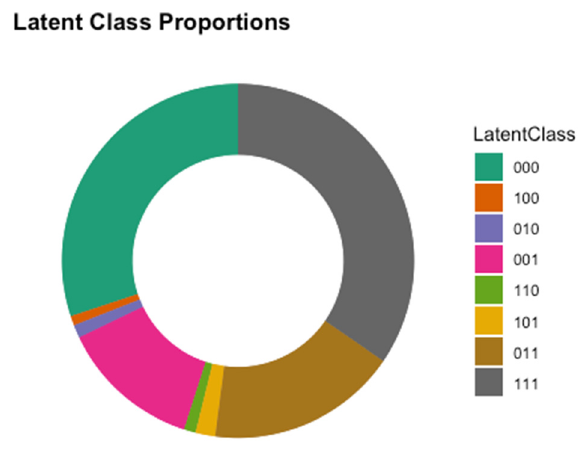
Figure 8. The doughnut chart of latent class proportions.